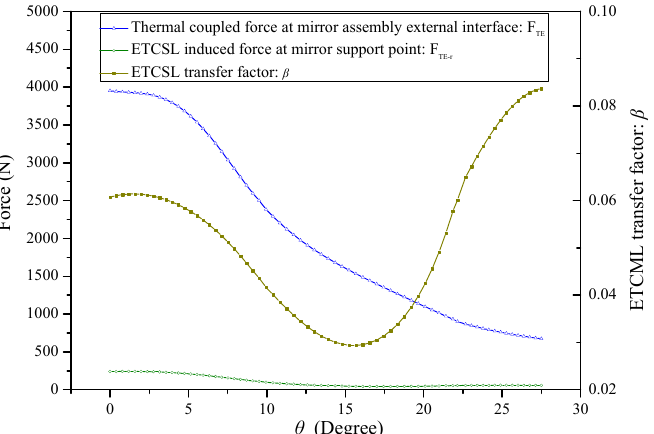
Figure 13. Relationships between the AEIF semi-arc angle ( θ ) and the ETCML ( F TE ), the ETCML induced reaction force ( F TE − r ), and the ETCML transfer factor ( β F ).